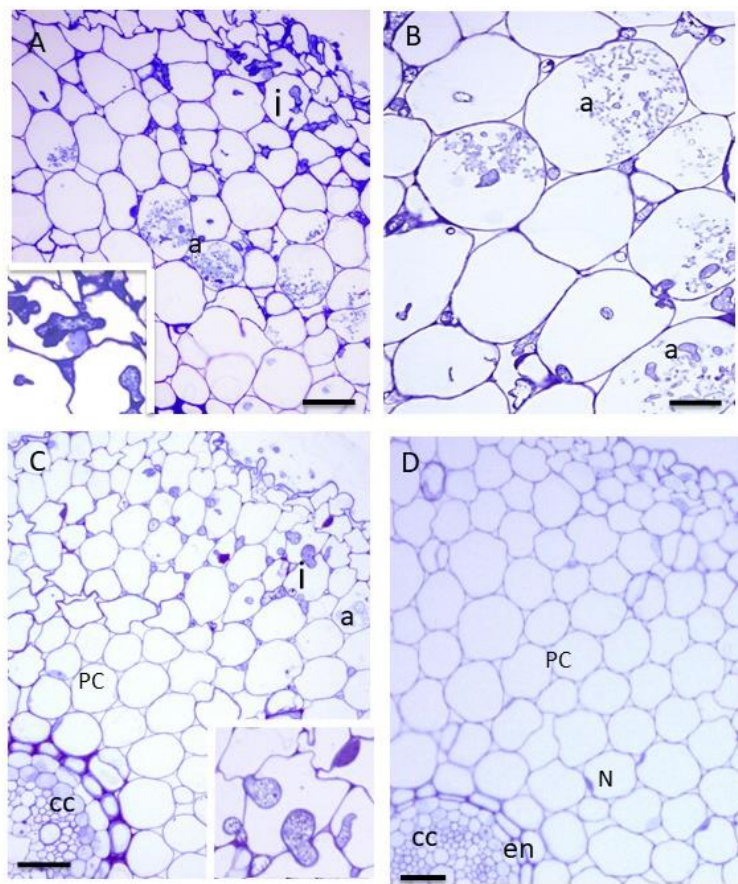
Figure 1. Light microscope images of semi-thin sections of Crocus sativus roots inoculated with Rhizophagus intraradices and Funneliformis mosseae (Ri+Fm, A ), R. intraradices alone (Ri, B and C ) or the control (arbuscular mycorrhizal fungi (AMF)-, D ), stained with toluidine blue. At the level of the cortical cells, note the presence of intercellular and intracellular hyphae (i) and arbuscules (a). Magnification in insets A and C shows details of the intracellular hyphae. Cortical parenchyma (PC) cells with nucleus (N) are indicated. No fungal structure is present between and inside the root cells in AMF-roots (D). Note the central cylinder (cc) and the endodermide (en). Bars are 20 μm in A, C and D, and 10 μm in B .